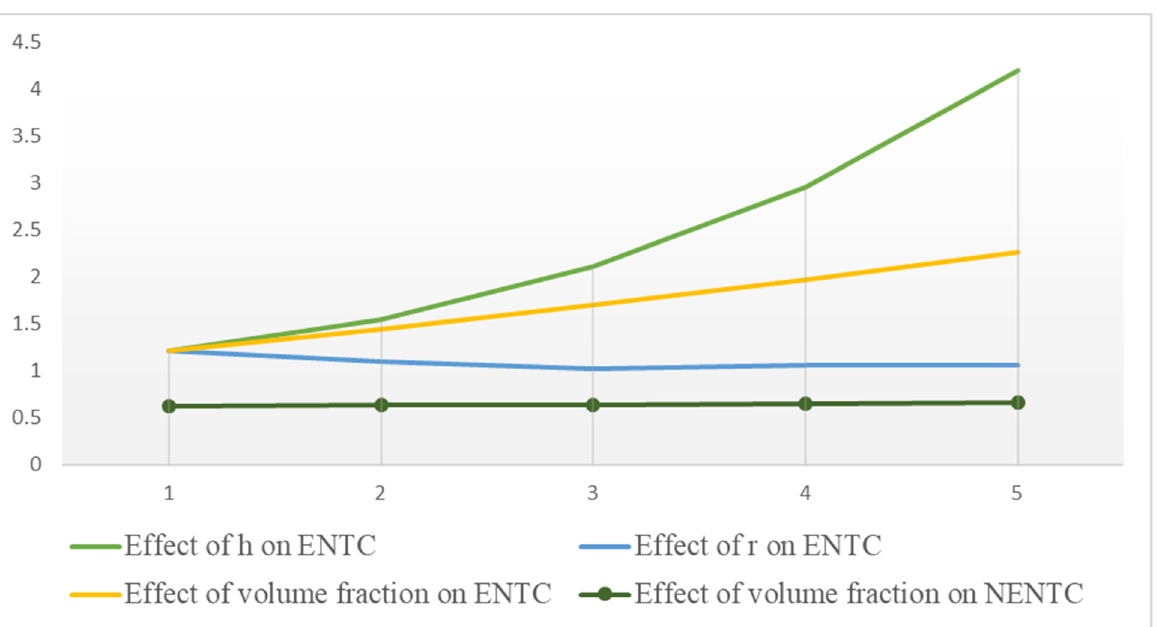
Figure 6. Effect of thermal conductivity and effective thermal conductivity. Table 3. Variation in shear stress, heat, and mass transfer rate for suction and injection cases at the lower plate.